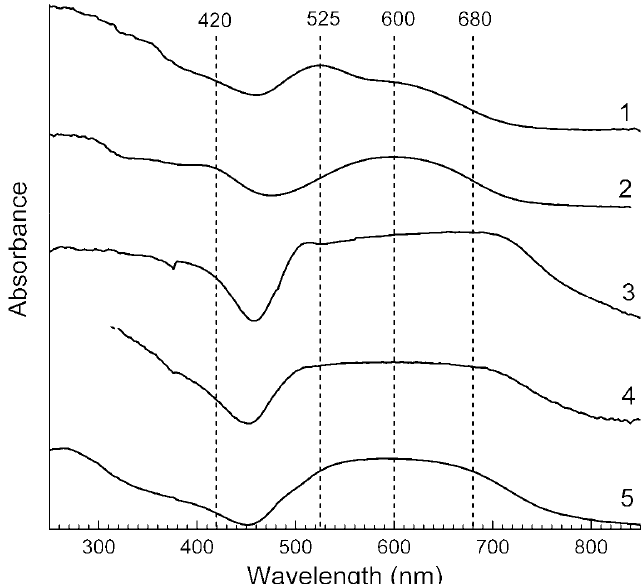
Figure 12. UV-Vis absorption spectra of: 1—LSh; 2—MD; 3—PH; 4—KL; 5—ZK.